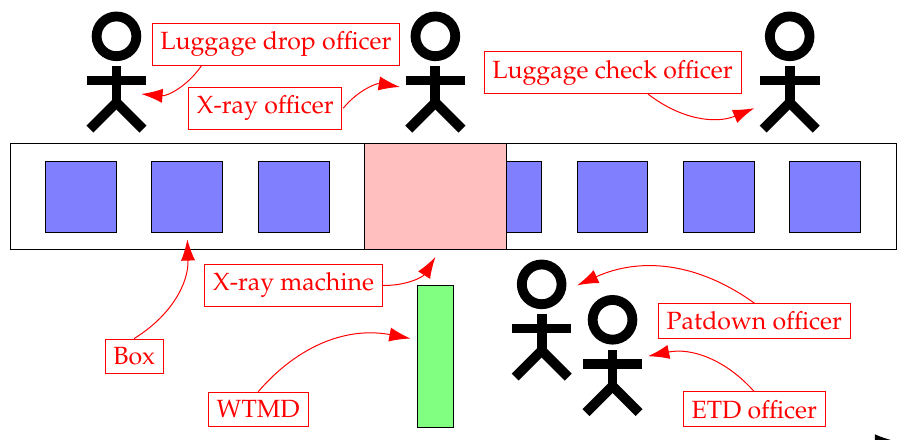
Figure 1. Graphical representation of a security checkpoint lane with its employees. The most important elements are labelled. The black line indicates the direction in which the passenger